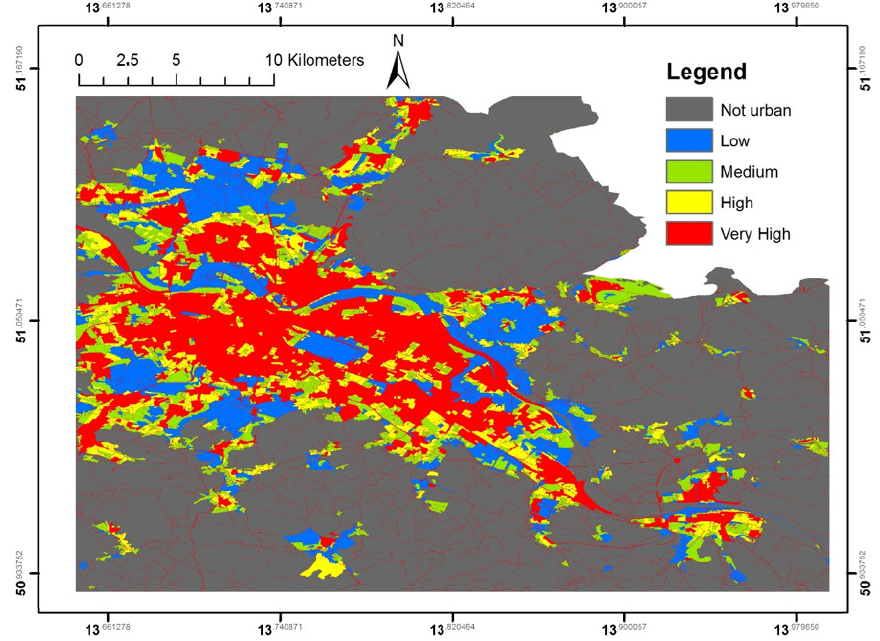
Figure 7. Dresden area (Germany). SAR-Derived urban density map obtained by applying the proposed methodology to the input Level-1 β product depicted in Figure 5. The result has been projected into the Urban Atlas polygons for comparison with the reference data. Table 2. Dresden: confusion matrix for the urban/not urban classification using reference data derived from the Urban Atlas. Proposed methodology—overall accuracy: 83.61%, kappa coefficient: 0.64. Urban density windows ~150 m and ~450 m. Speckle divergence—overall accuracy: 79.45%, kappa coefficient: 0.38. Threshold set to 0.6.